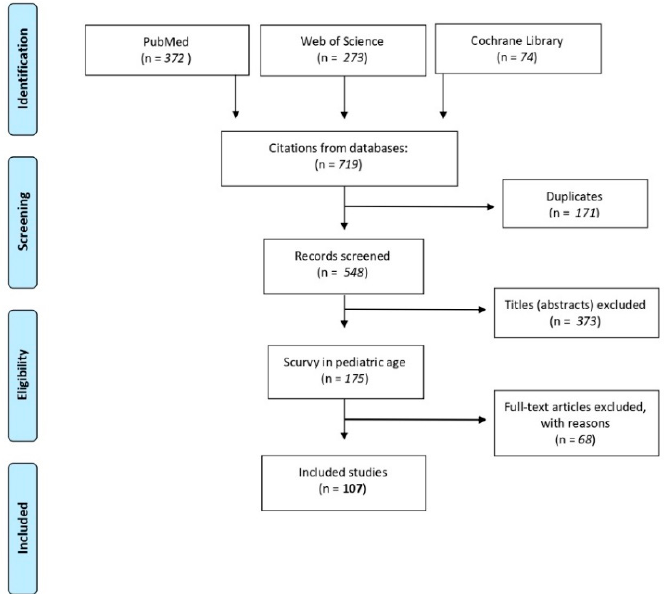
Figure 4. PRISMA Figure 4. PRISMA flowchart.